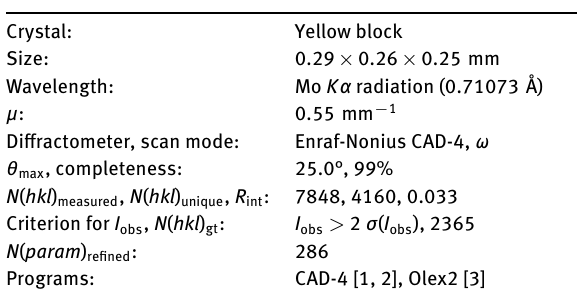
Table 1: Data collection and